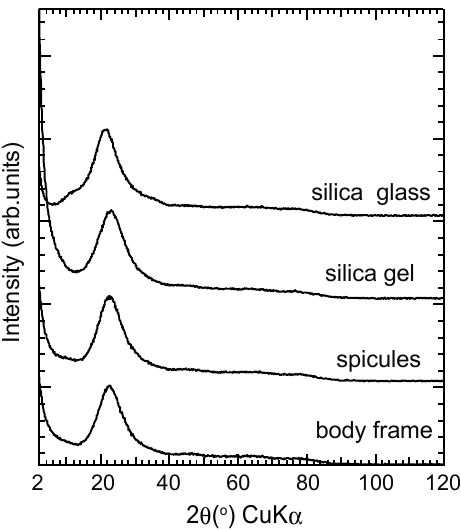
Figure 10. XRD patterns for body frame, spicules, silica gel, and silica glass.